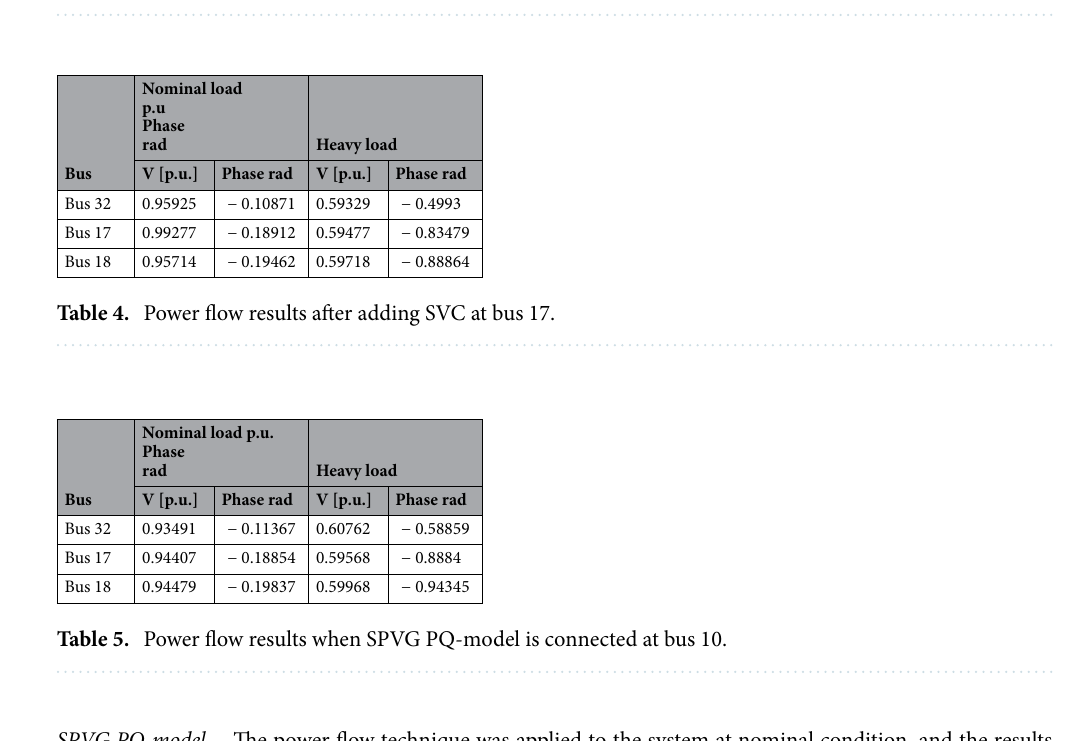
Table 5. Power flow results when SPVG PQ-model is connected at bus 10.